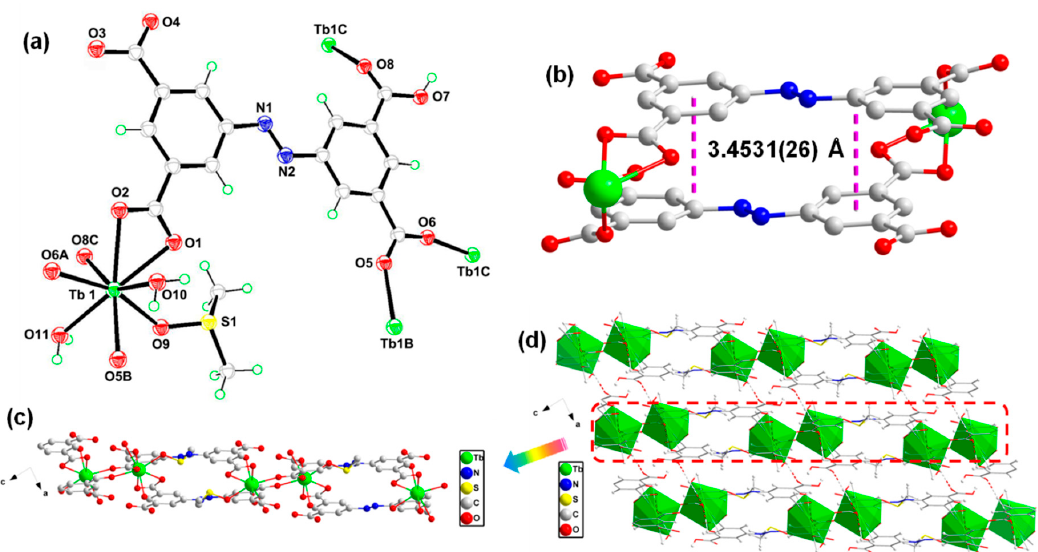
Figure 1. ( a ) Representation of the coordination environment of the Tb ion in